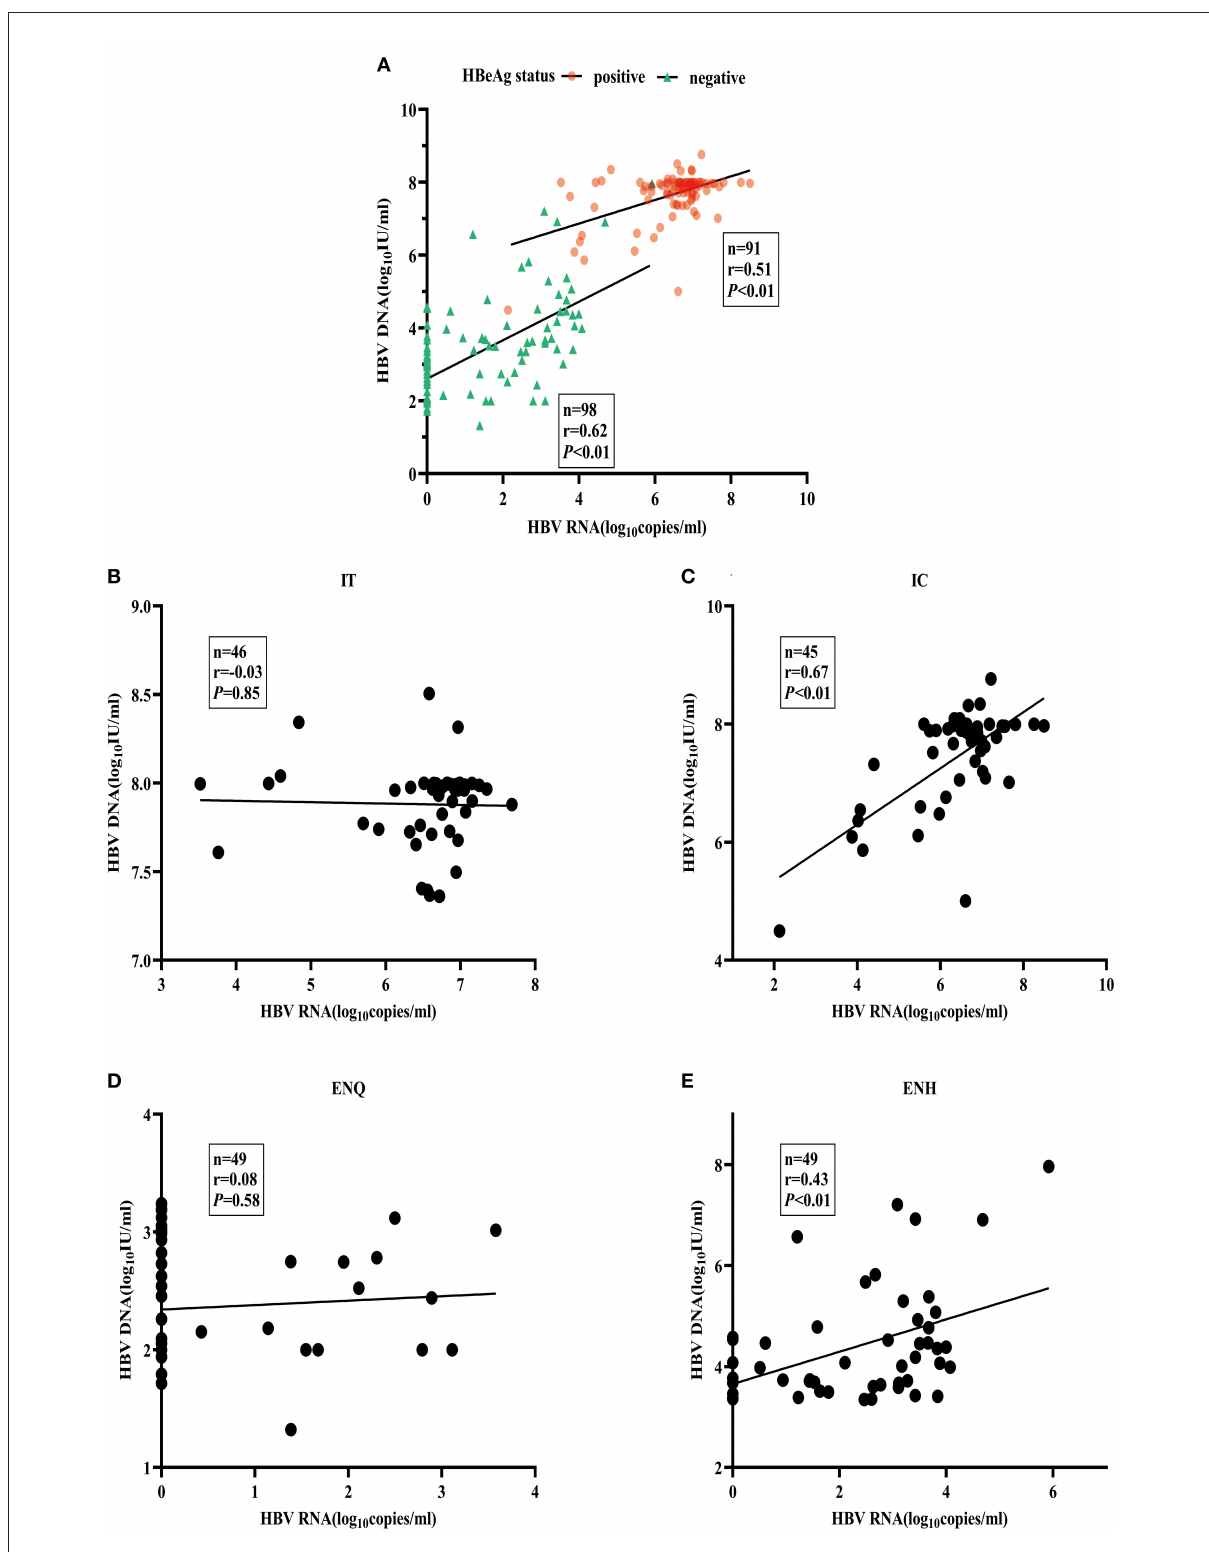
FIGURE2 Association between serum HBV RNA and HBV DNA. (A) HBV RNA and HBV DNA by HBeAg status. (B) HBV RNA and HBV DNA in the IT phase. (C) HBV RNA and HBV DNA in the IC phase. (D) HBV RNA and HBV DNA in the ENQ phase. (E) HBV RNA and HBV DNA in the ENH